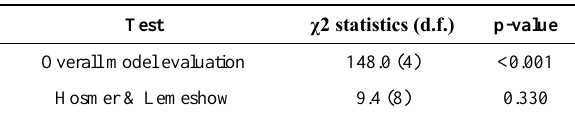
Table 5. Diagnostic tests of the logistic model.